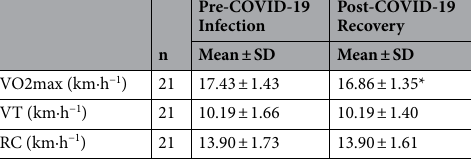
Table 5. Running velocities at VO 2max ( V VO 2max ), VT ( V VT) and RC ( V RC). *p < 0.05, **p <